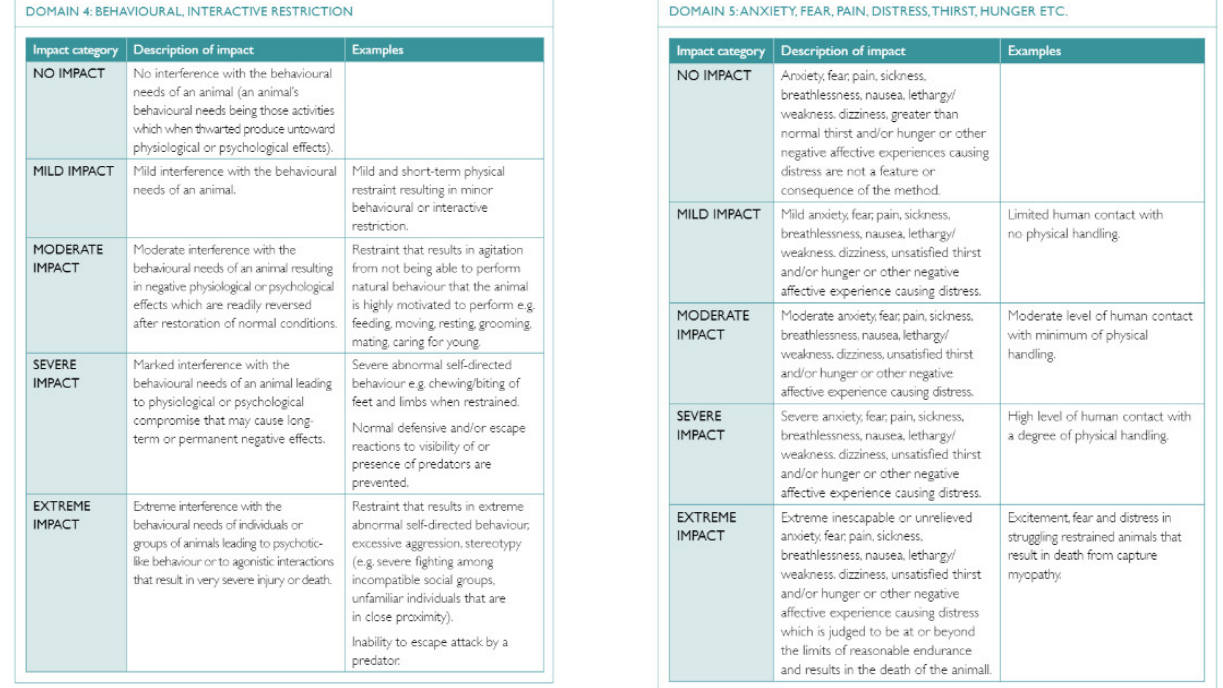
Figure 2. Examples of the impact scales (Domain 4 and Domain 5) to be used as a reference by panel members when applying the Sharp and Saunders model [18]. Reprinted from A model for assessing the relative humaneness of pest animal control methods. Second edition. (pp. 47–48), by T. Sharp and G. Saunders, 2011, Australian Government Department of Agriculture, Fisheries and Forestry. Reprinted with authors’